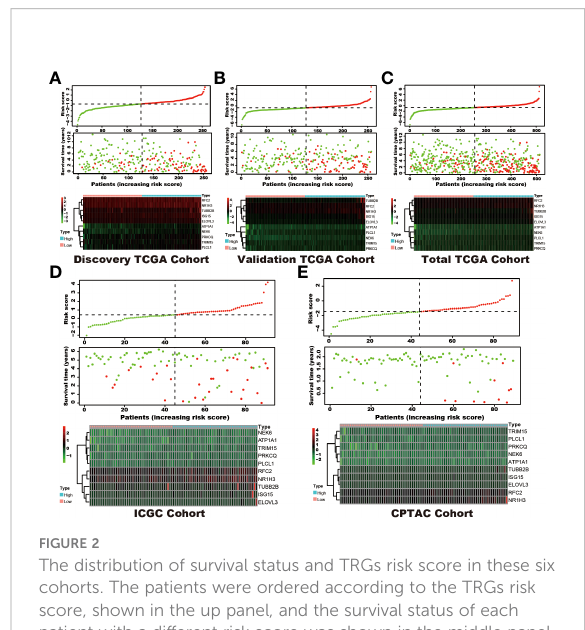
FIGURE 2 The distribution of survival status and TRGs risk score in these six cohorts. The patients were ordered according to the TRGs risk score, shown in the up panel, and the survival status of each patient with a different risk score was shown in the middle panel. The TRGs risk model gene expression value has presented in the lower panel. (A) discovery TCGA cohort; (B) validation TCGA cohort; (C) total TCGA cohort; (D) ICGC cohort; (E) CPTAC cohort.